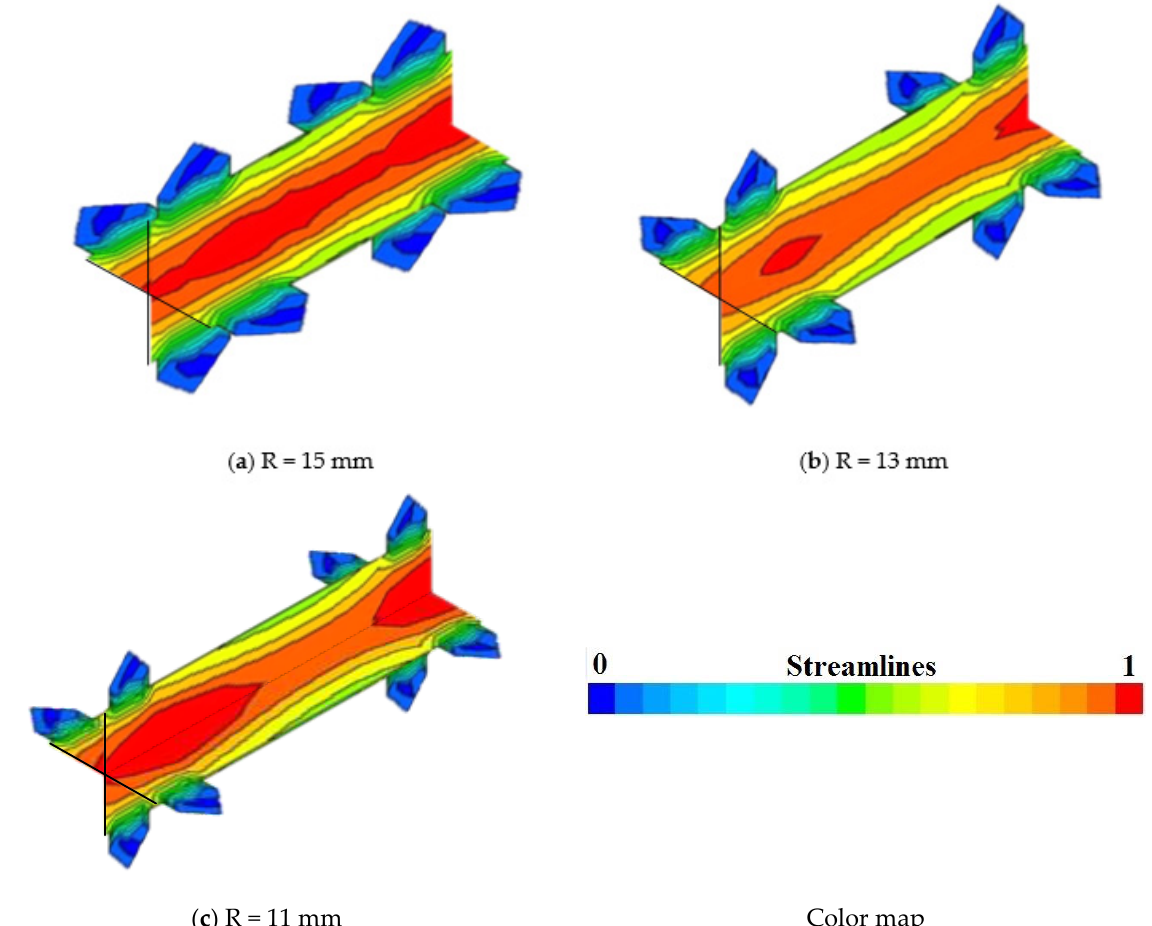
Figure 4. Streamlines for various configurations of Case A with different R parameters at A 2 = 24 mm, Re = 15,000, and 𝜑 = 0.5%.